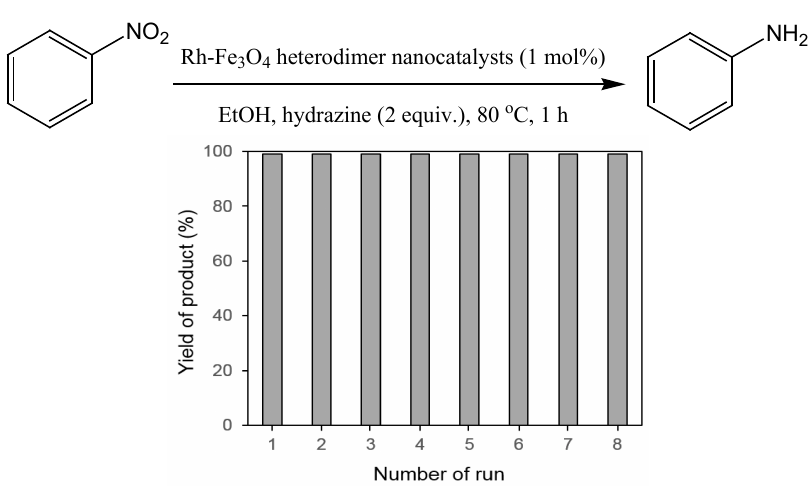
Figure 5. Recycling for the magnetic Rh-Fe 3 O 4 heterodimer nanocatalysts in the reduction of